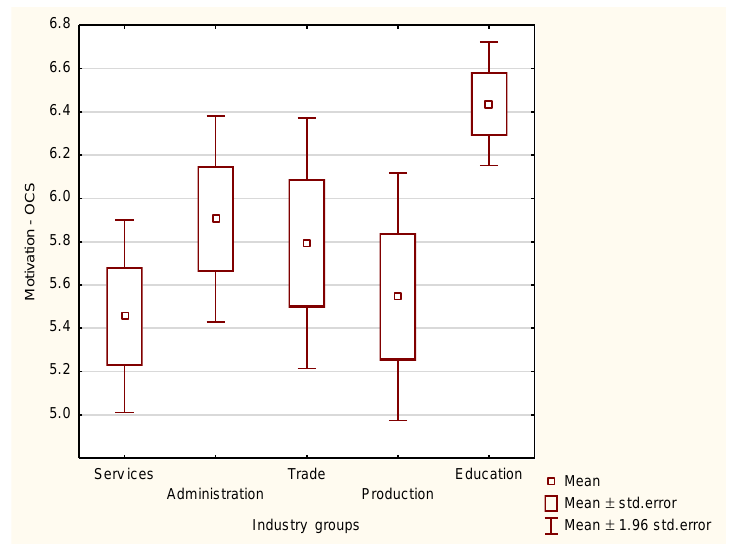
Figure 14. Own C&S as a factor shaping the means of movement in various industry groups. The highest level of guidance by one’s own comfort and safety was demonstrated by respondents in the 35–44 age group. The Kruskal–Wallis rank ANOVA test provided a test value of 5.9, and the test probability p = 0.05 indicates significant differences in the level of motivation the OCS criterion provided when choosing a means of transport, as shown in Figure 15.